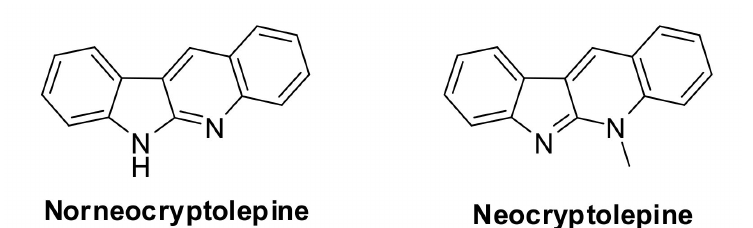
Figure 1. Natural alkaloids with quinindoline core